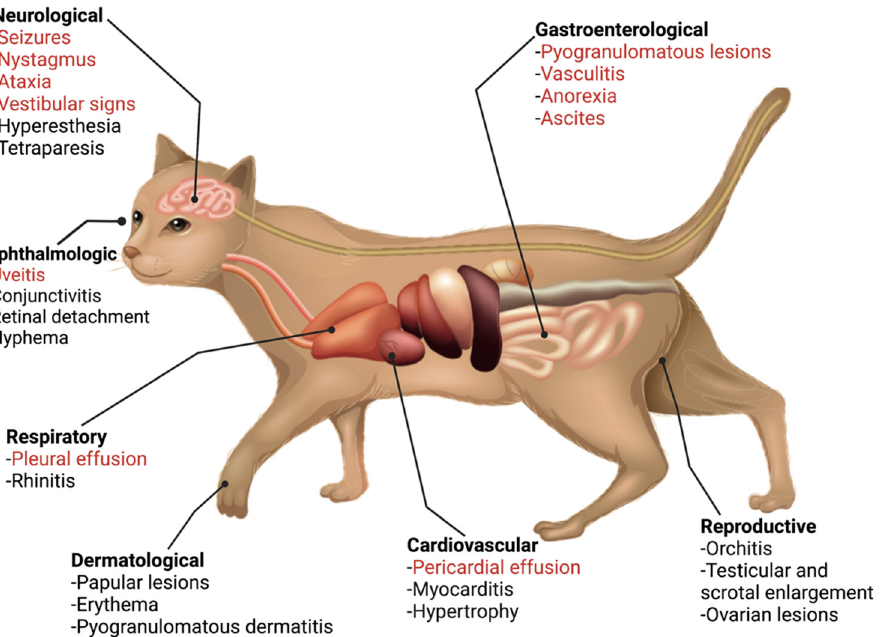
Figure 2. Summary of the systemic clinical signs and pathologies associated with FIP. FIP is well known to be a systemic infection with a diverse presentation. The possible systemic clinical signs associated with FIP, encompassing the organ systems that are also affected by COVID-19, are summarized. The most common signs of FIP are colored in red.